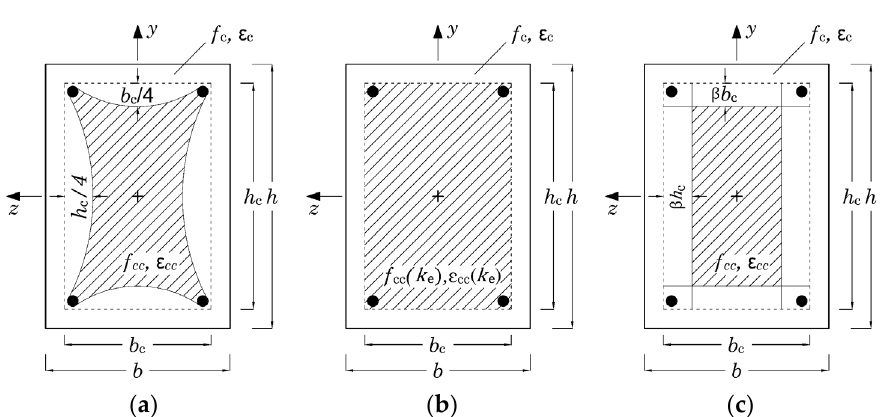
Figure 4. Comparison between methods for discretization of the cross-section: ( a ) expected confined area, ( b ) modeling according to Mander et al. [17], ( c ) proposed modeling.